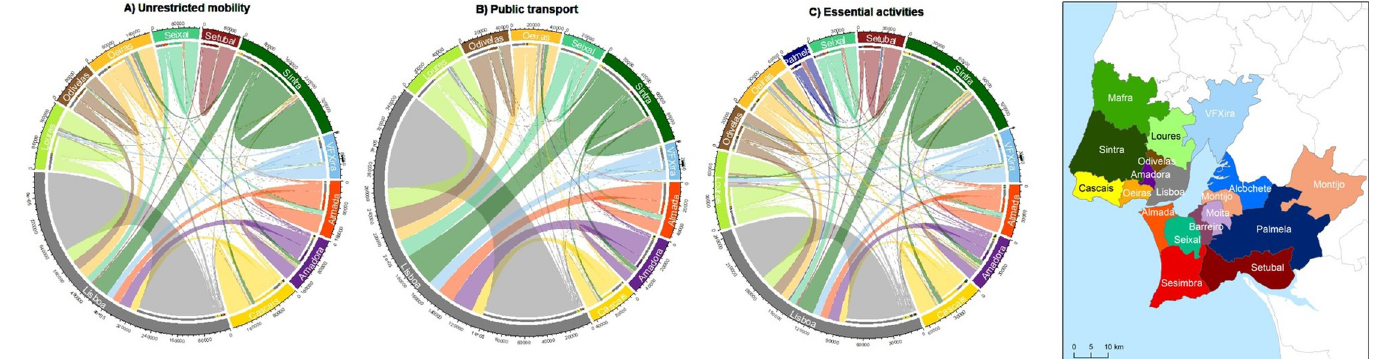
Fig 2. Daily flows amongst LMA municipalities. A) unrestricted mobility with all transport modes (data of 2011); B) mobility based on the use of collective public transport; C) mobility restricted to essential activities Origin is identified by the color of the corresponding municipality, shown in the map on the right. The degree of flows is represented by the width of the colored links. To facilitate visualization, flows representing less than 3% of the total were excluded. Graphs were made with circlize package in R software [25]. Longer names of municipalities were reduced for simplification: VFXira = Vila Franca de Xira. Source of data: Statistics Portugal (INE, 2011).